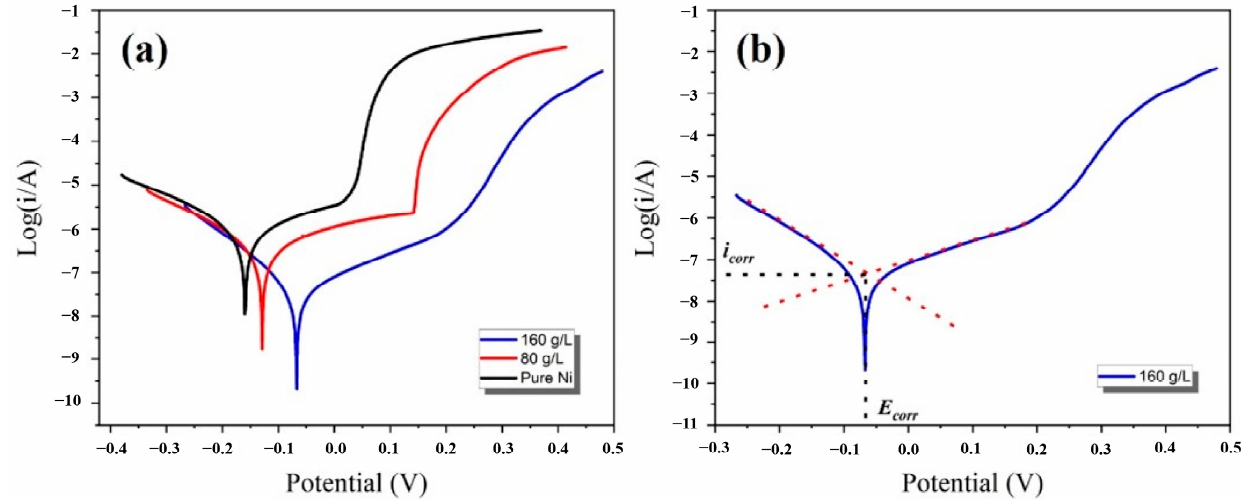
Figure 8. ( a ) Tafel plots of the composite coatings; ( b ) diagram of Tafel extrapolation